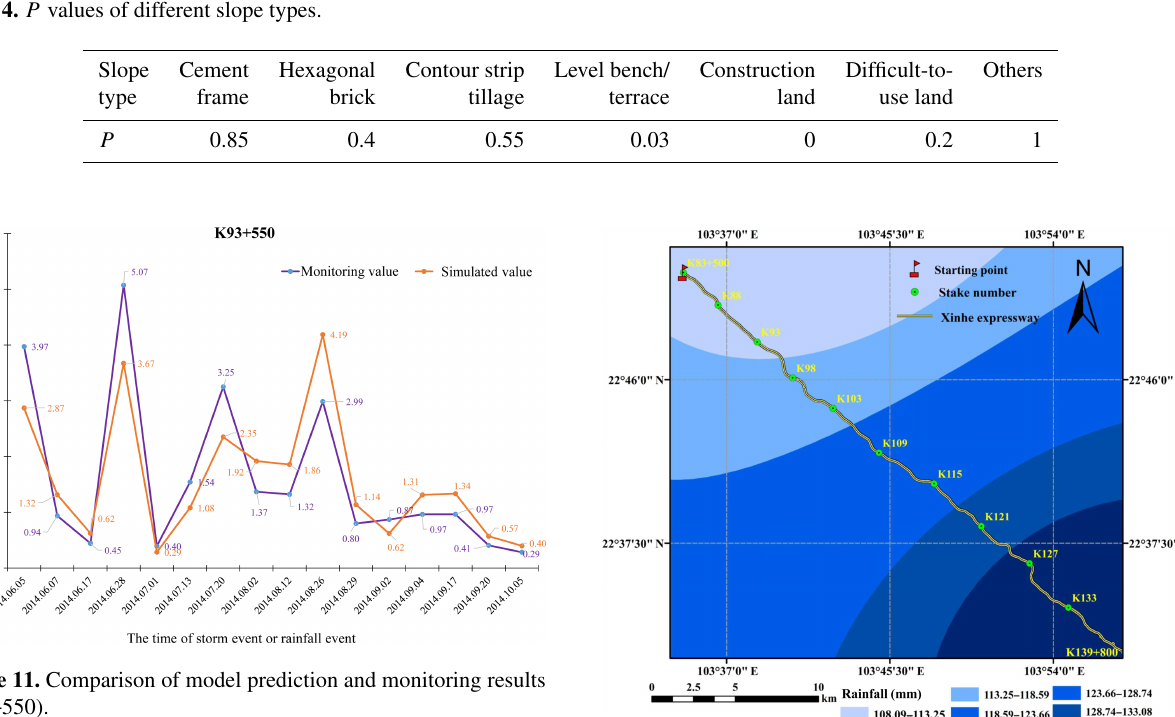
Table 4. P values of different slope types.